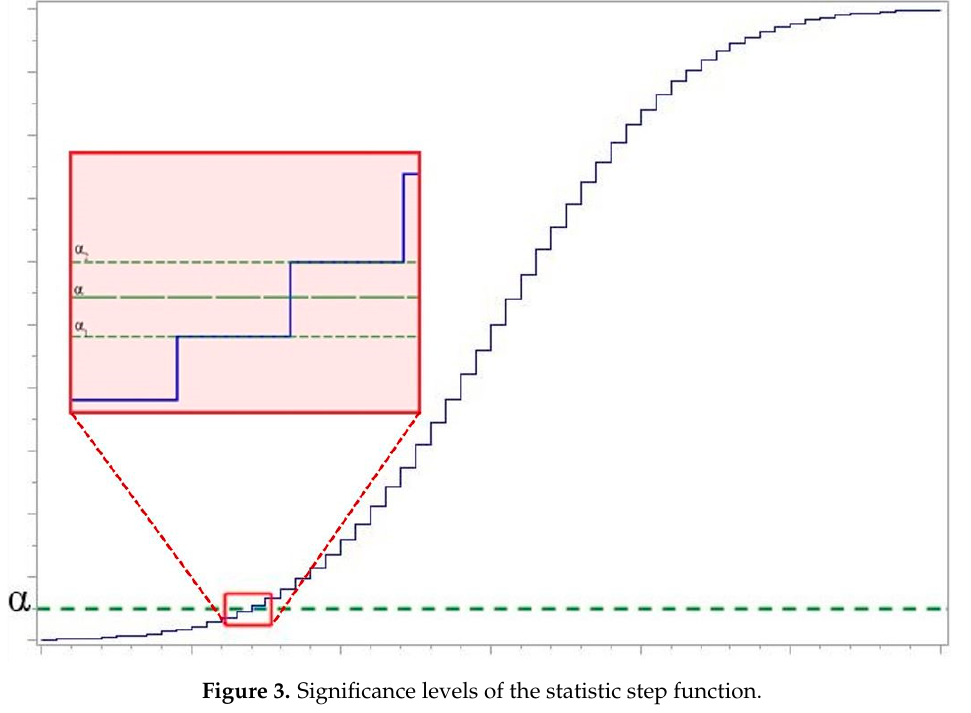
Figure 3. Significance levels of the statistic step function.